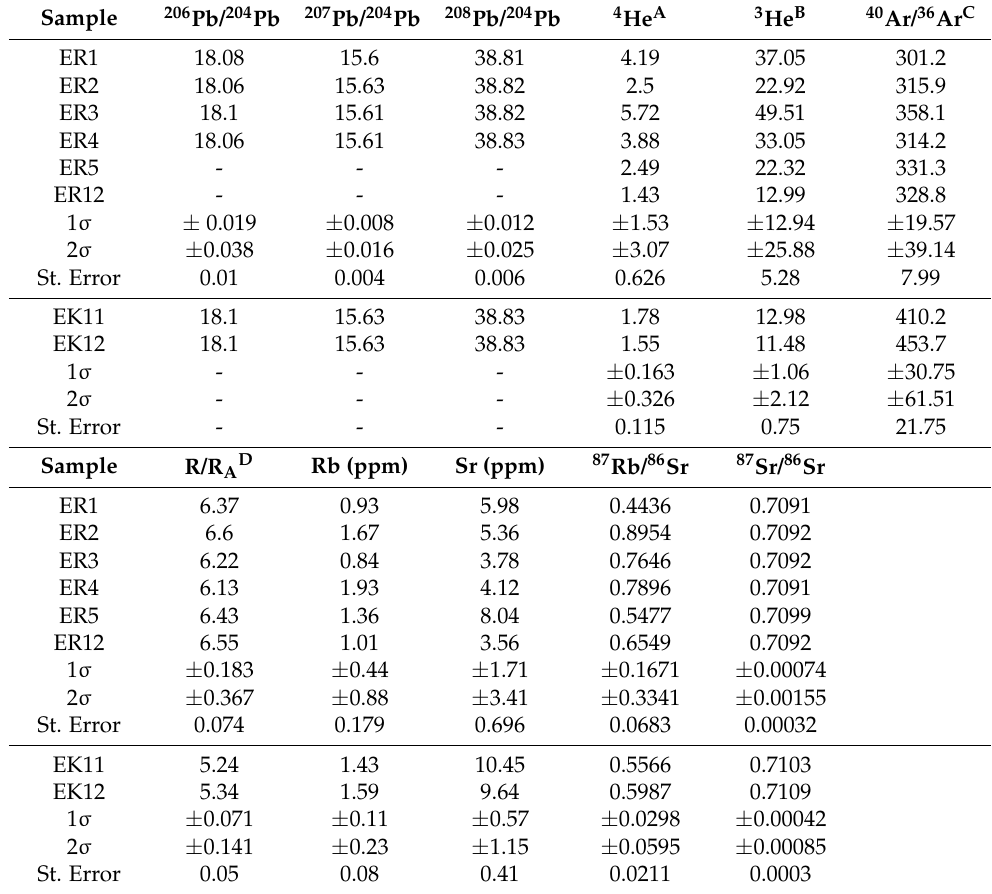
Table 1. Radiogenic isotope data (Pb, He-Ar, and Rb-Sr) from Ermioni VMS (EK—Karakasi VMS, ER—Roro VMS) (radiogenic isotope data taken from [27]).